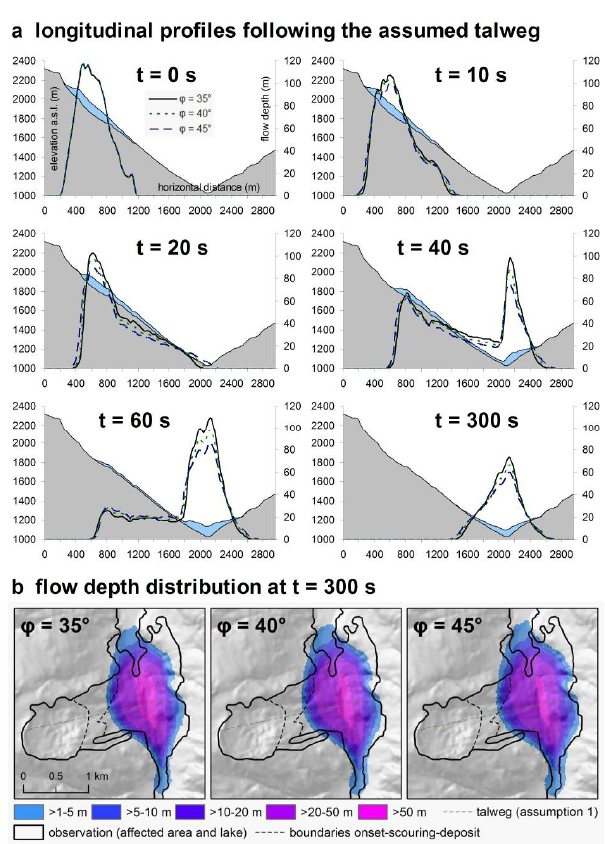
Fig. 12: (a) Longitudinal profiles of the flow at different time steps with δ = 22°: comparison Fig. 12. (a) Longitudinal profiles of the flow at different time of the results with φ = 35, 40 and 45° with a cell size of 20 m – the flow depth for φ = 35° is steps with δ = 22 ◦ : comparison of the results with φ = 35, 40 and 45 ◦ with a cell size of 20m – the flow depth for φ = 35 ◦ is also also shown proportionally to the terrain; (b) flow depth distribution after t = 300 s for three shown proportionally to the terrain; (b) flow depth distribution after different assumptions of φ . t = 300s for three different assumptions of φ